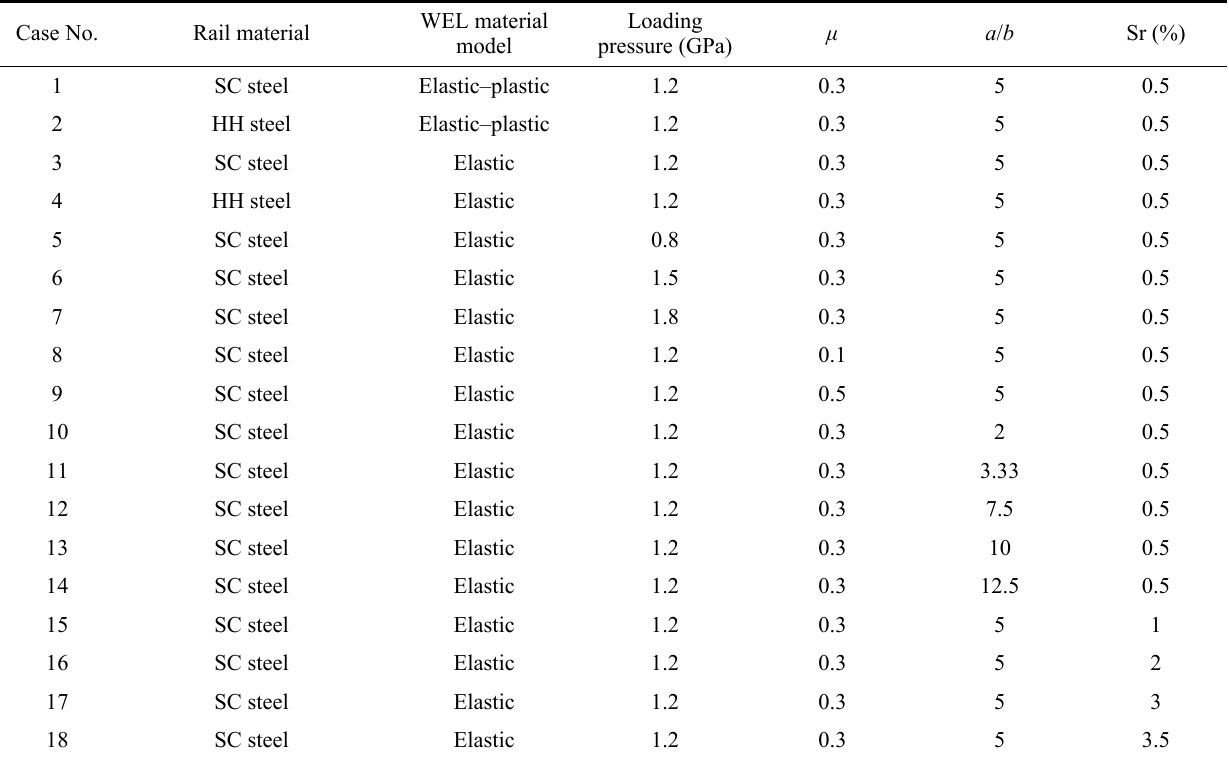
Table 3 Summary of finite element simulations conducted in this study and the corresponding details of the simulation conditions. Case